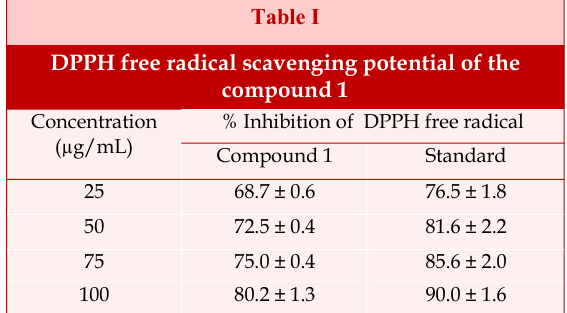
Figure 1: Structure of the compound 1 (5- methoxy-2-methyl- 3-pentacosyl-1,4 benzoquinone)